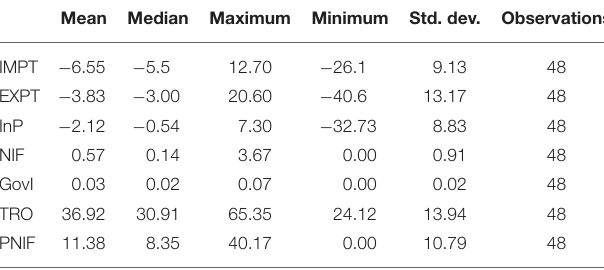
TABLE 1 | Summary statistics of selected variables from January 2020 to December 2020. Mean Median Maximum Minimum Std. dev. Observations